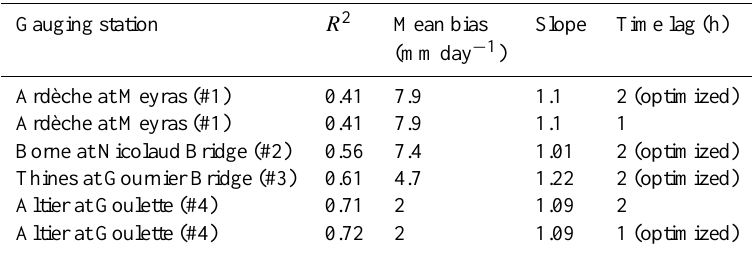
Table 8. Model performance of inferred versus measured daily rainfall in four sub-catchments for all low-vegetation periods 2000–2008. Gauging station R 2 Mean bias Slope Time lag (h) (mmday − 1 ) Ardèche at Meyras (#1) Borne at Nicolaud Bridge (#2) Thines at Gournier Bridge